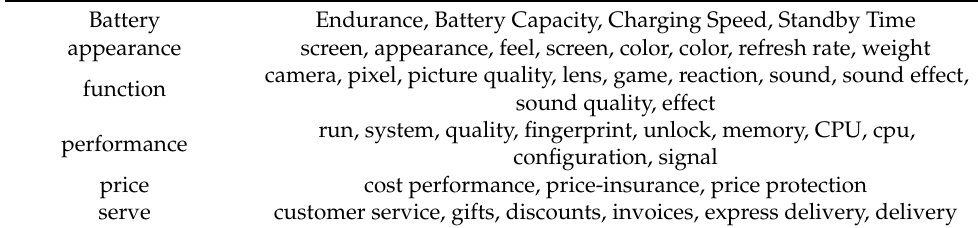
Table 2. Evaluation Feature